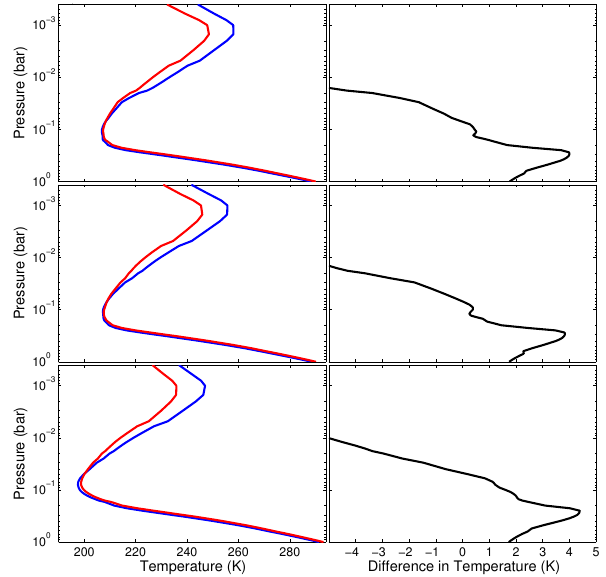
Figure 2. Modern Earth temperature profiles. Pre-industrial (blue) and doubled CO 2 (red) temperature profiles for (a) low-, (c) mid-, and (e) high-H 2 O parametrizations. Corresponding changes in tem- perature for (b) low-, (d) mid-, and (f) high-H 2 O parametrizations. Grey line shows the global and annual mean modern-day tempera- ture